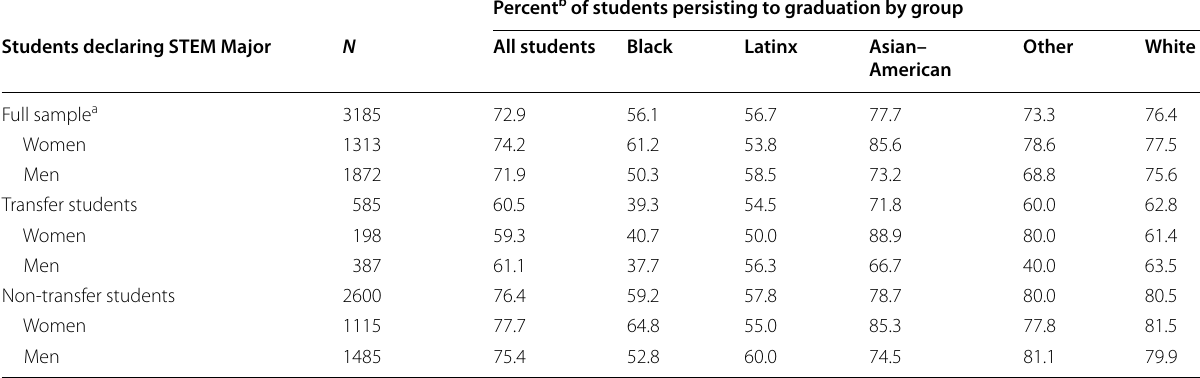
Table 1 Percent of students persisting from STEM major declaration to graduation by race, gender, and community college attendance: North Carolina High School Class of